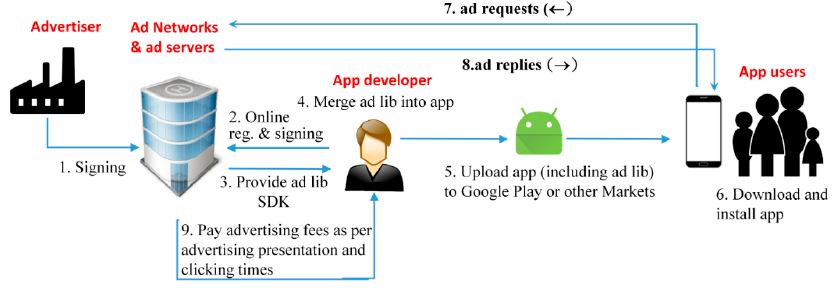
Figure 1. Ad lib operation flowchart.